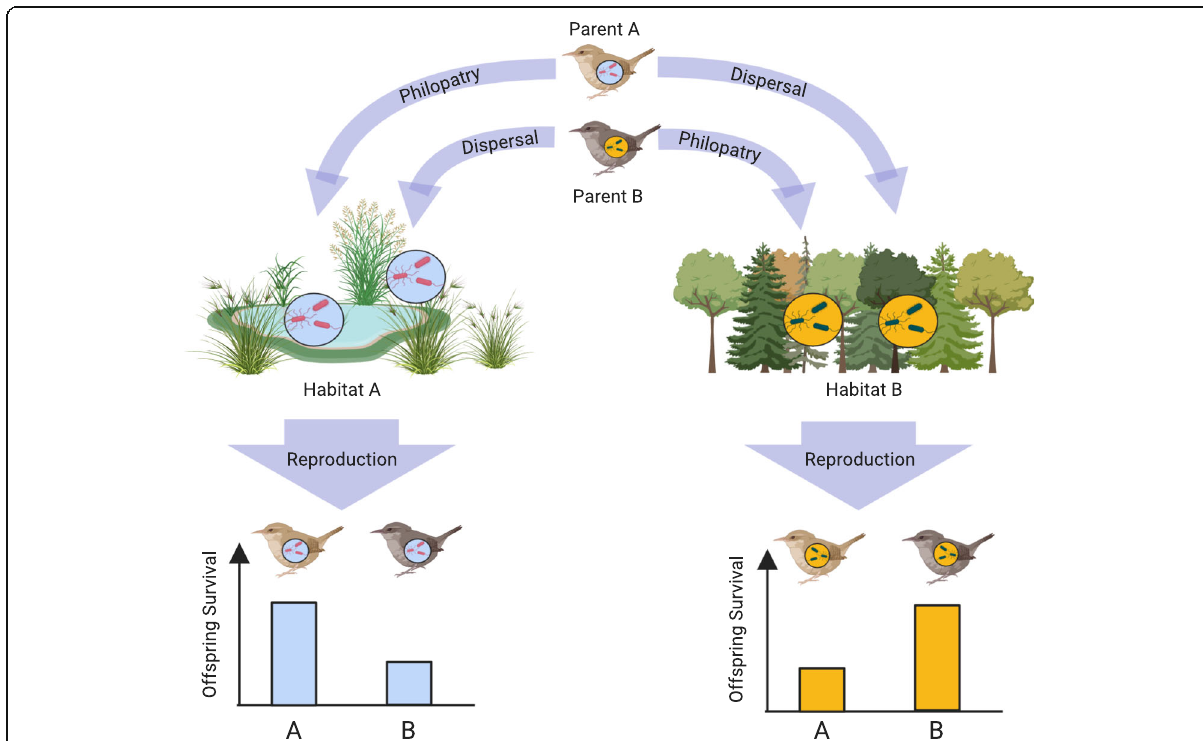
Fig. 1 Diagrammatic representation of how host-microbe interactions may influence reproductive success of philopatric or dispersing individuals. Individuals that exhibit philopatry maintain optimal Genome Host x Genome Microbial x Environment interactions. Conversely, individuals that disperse experience incompatibility in Genome Host x Genome Microbial x Environment interactions, and suffer fitness